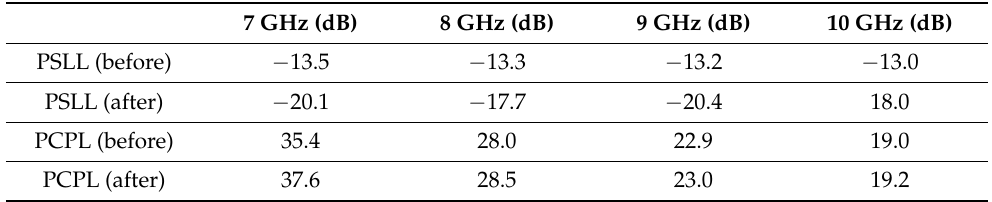
Table 7. The PSLLs and PCPLs of the 8-element linear array before and after applying the proposed low PSLL beampattern synthesis approach at 7 GHz, 8 GHz, 9 GHz and 10 GHz.